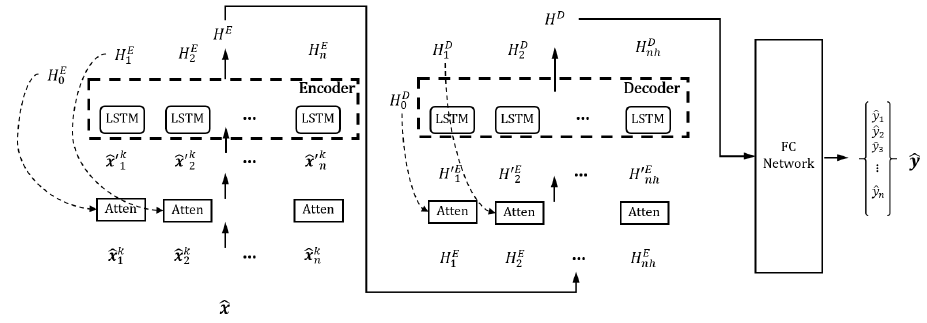
Figure 8. Details of the proposed attention-based LSTM predictor